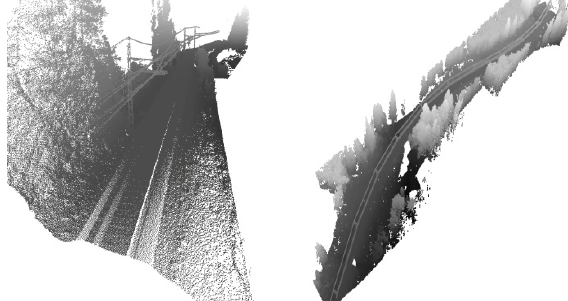
Figure 5. Oblique view on the point cloud from Area 1 (left, 2.2M points) and Area 2 (right, 4.2M points).